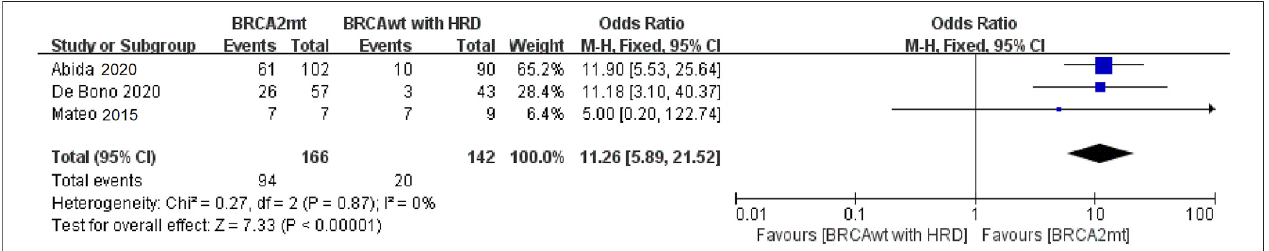
FIGURE 4 | Forest plots of pooled analyses for the effect of PARP inhibitors on ORR in BRCA2 mutation vs. BRCA wild-type HRD patients; Abbreviations: HRD, homologous recombination de fi ciency; ORR, overall response rate; PFS6/12, progression-free survival rates at 6/12